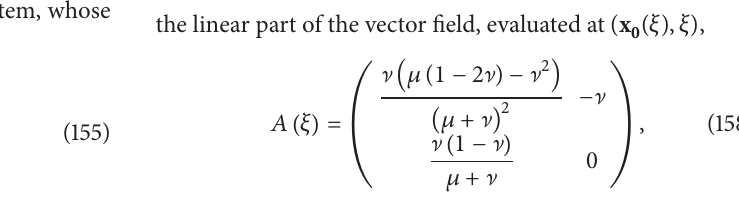
Figure 3 emphasizes the comparison between the curve of of (139) obtained numer- nonhyperbolic periodic orbits 𝐶 NH ically with the software MATCONT (see [5]) and the quad- ratic approximation (154).